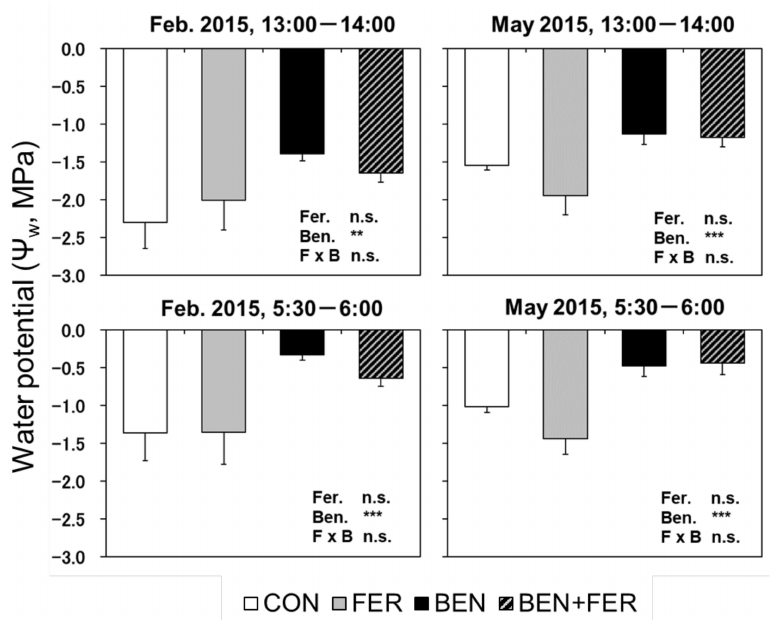
Figure 4. Leaf water potential in the afternoon (13:00–14:00) and predawn (05:30–06:00) for teak seedlings grown in the four treatments during February and May 2015 (mean ± SE, n = 9). Asterisks indicate significant differences by two-factor ANOVA. ** = p < 0.01 and *** = p < 0.001. Note. n = 6 in the FER. and BEN + FER. treatments from May 2015 because of dead seedlings.